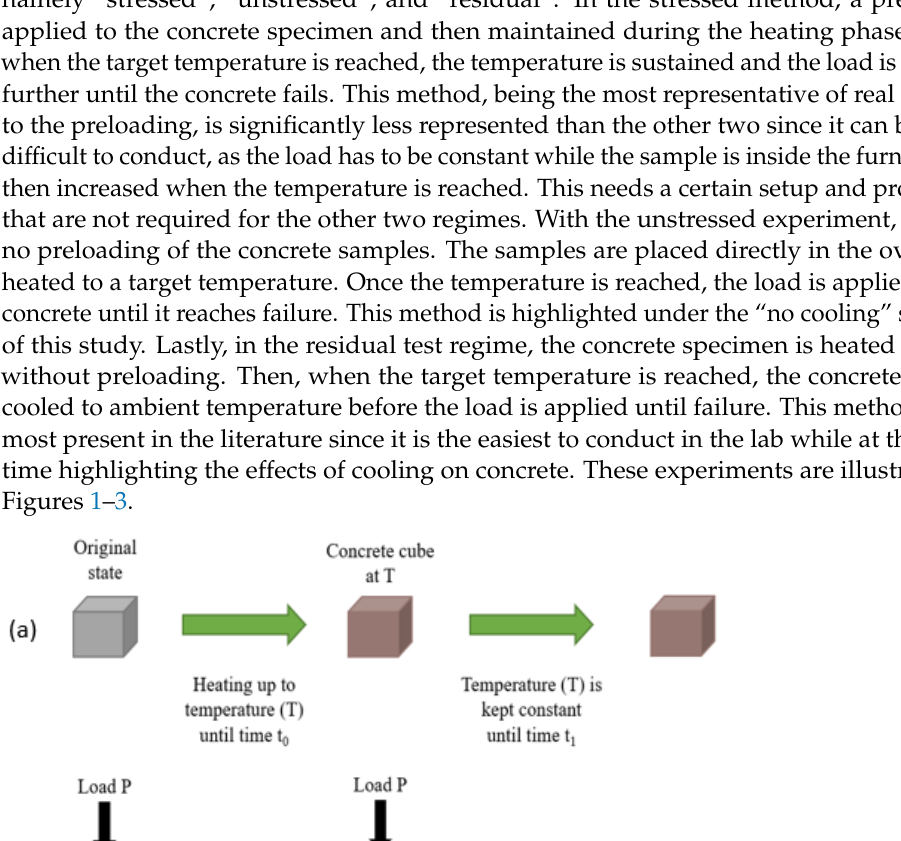
Figure 2. ( a ) Heating and ( b ) loading schemes of the unstressed condition. Figure 3. ( a ) Heating and ( b ) loading schemes of the residual condition.